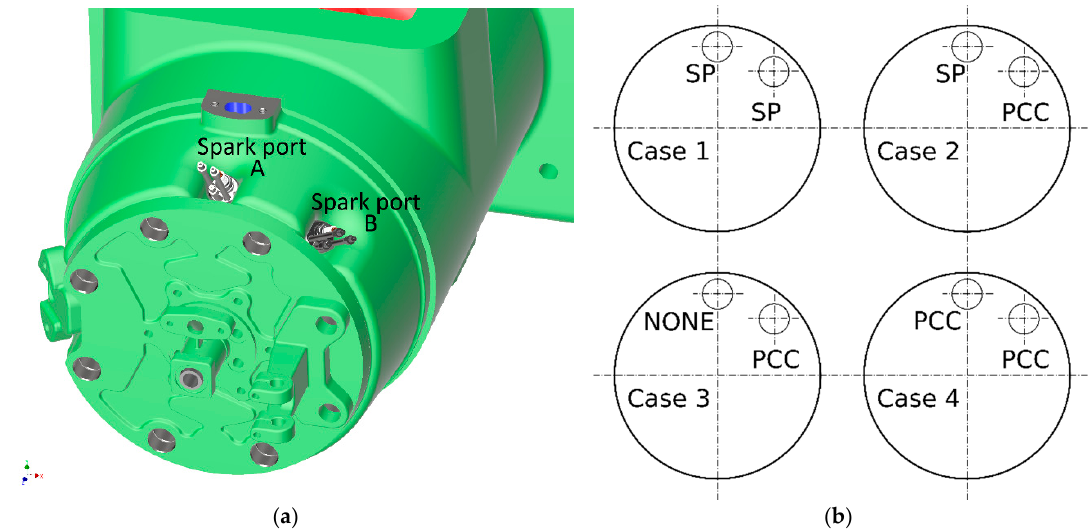
Figure 3. ( a ) Location of spark plug (SP) or pre-combustion chamber (PCC) in cylinder head; ( b ) Configurations of investigated ignition system.